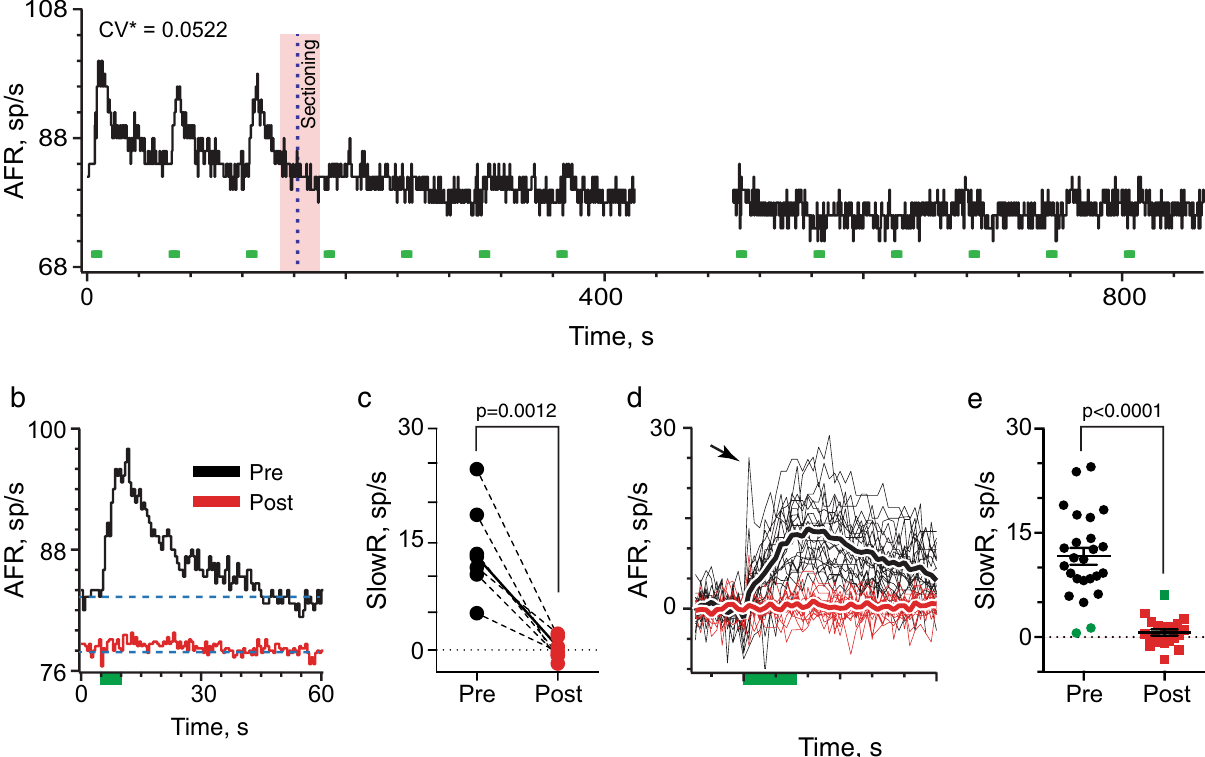
Figure 2. Electrical activation of vestibular efferents in the brainstem accounts for slow excitation of vestibular afferents. ( a ) Continuous response histogram from a regular afferent shows changes in afferent firing rate (AFR) during midline efferent stimulation (green bars, 333/s for 5 s every 60 s) before and after severing EVS neurons. Red box and dashed line indicate timing of a rostrocaudal cut in the brainstem using a small myringotomy blade mounted on a micromanipulator. Gap in trace at t = 425 s represents a 1-min interval between adjacent trials in the same unit. ( b ) Corresponding average response histograms from the same afferent in panel ( a) were generated separately for 3 and 10 shock trains delivered before and after sectioning, respectively. ( c ) Mean peak slow excitation values, averaged from a 1-s block at t = 6–7 s, are plotted for seven afferents from seven animals before and after sectioning. Solid line depicts values from example in Panel ( b) . Indicated p value from comparisons made using a paired t test. ( d ) Forty-five individual afferent response histograms to efferent shock trains (green bar, 333/s for 5 s) delivered before (black, n = 25) or after (red, n = 20) sectioning. AFR for each unit is plotted as a displacement from background. Thick traces represent average response histograms for each population. Arrow points to prominent efferent-mediated fast excitation in one unit. ( e ) Mean peak slow excitation values, averaged from a 1-s block at t = 6–7 s, are plotted for the 45 afferents in panel ( d) . Population mean ± SEM are indicated by black bars. Solid green circles show pre-section units without efferent-mediated response while solid green square shows post-section afferent with a residual efferent-mediated response. Indicated p value from comparisons made using an unpaired t test. Binning in panels ( a , b , d) is 500